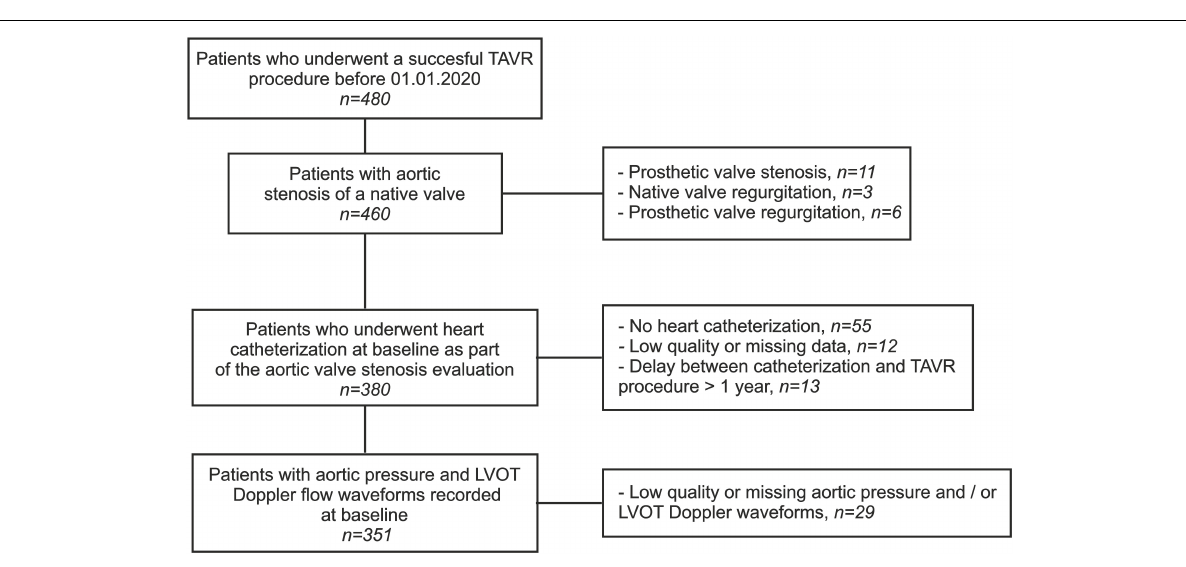
ED; Quartile 3 (Q3), n = 88, BWTT from 15.6 to 22.3% of the ED and; Quartile 4 (Q4), n = 88, BWTT ≥ 22.4% of the